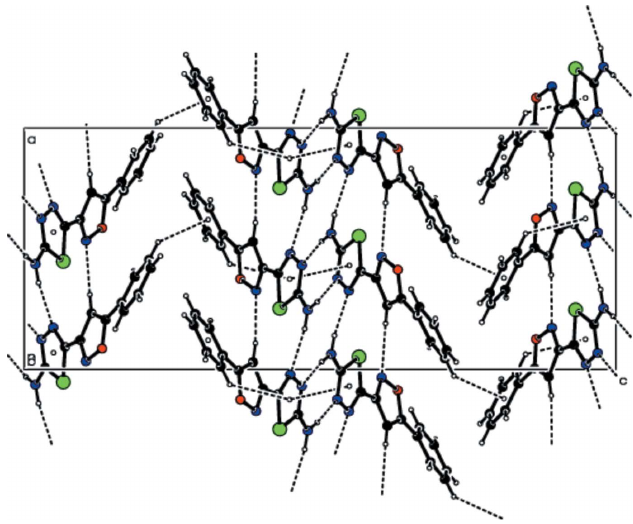
Figure 5 A view of the layer structure formed by intermolecular N—H (cid:2)(cid:2)(cid:2) N, C— H (cid:2)(cid:2)(cid:2) N, C—H (cid:2)(cid:2)(cid:2) (cid:2) and (cid:2) – (cid:2) interactions in the crystal structure of the title compound projected along the b axis.